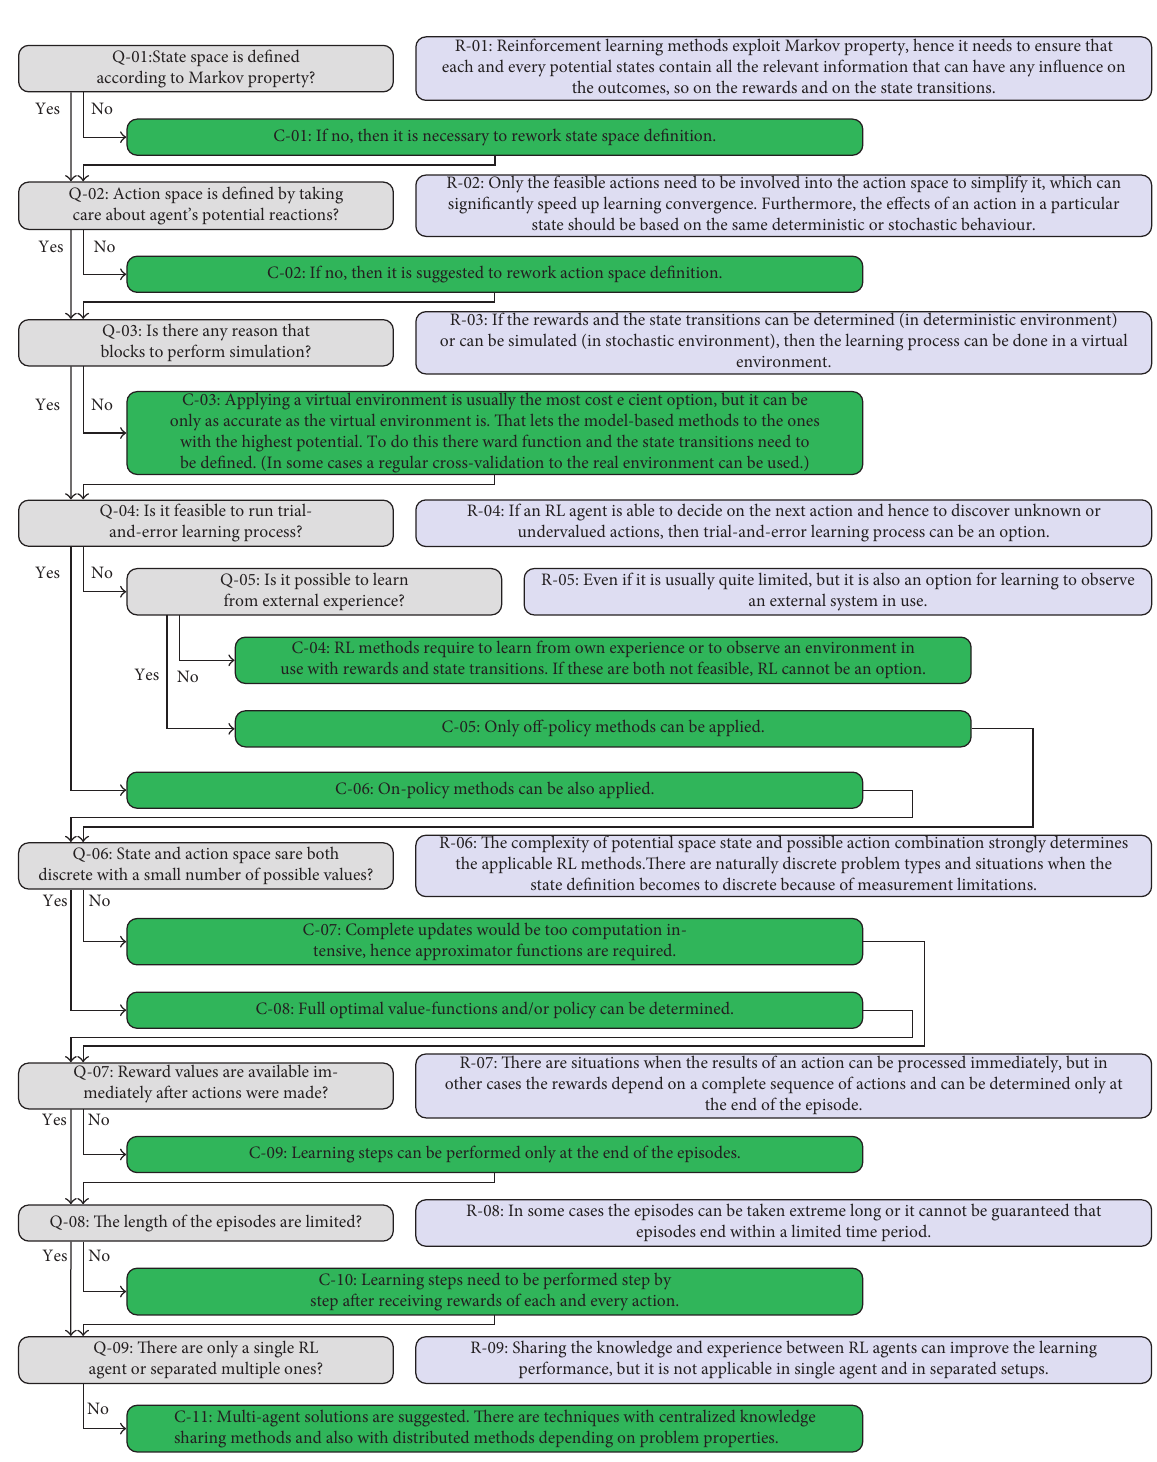
Figure 8: Guideline process to determine appropriate RL method to